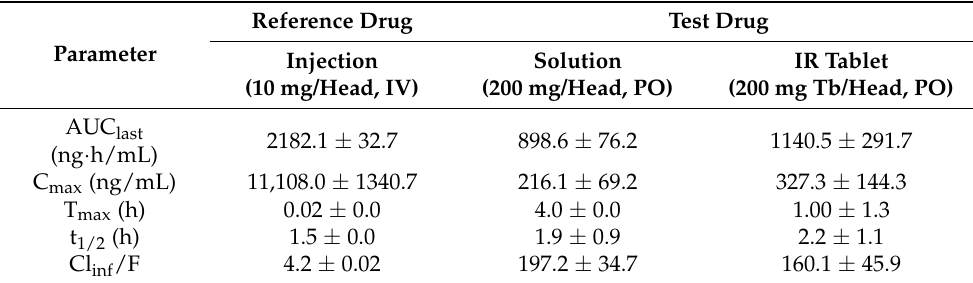
Table 7. PK study of reference drug and test drug: pharmacokinetics parameters.